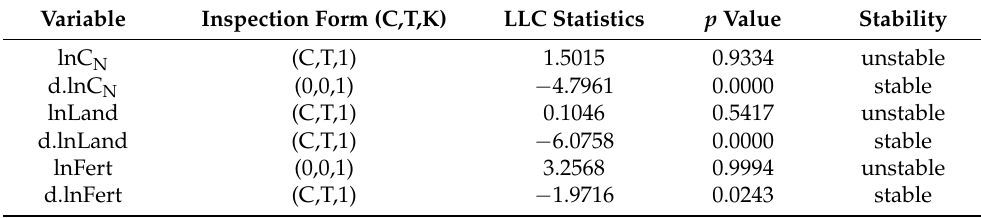
Table 7. LLC Unit root